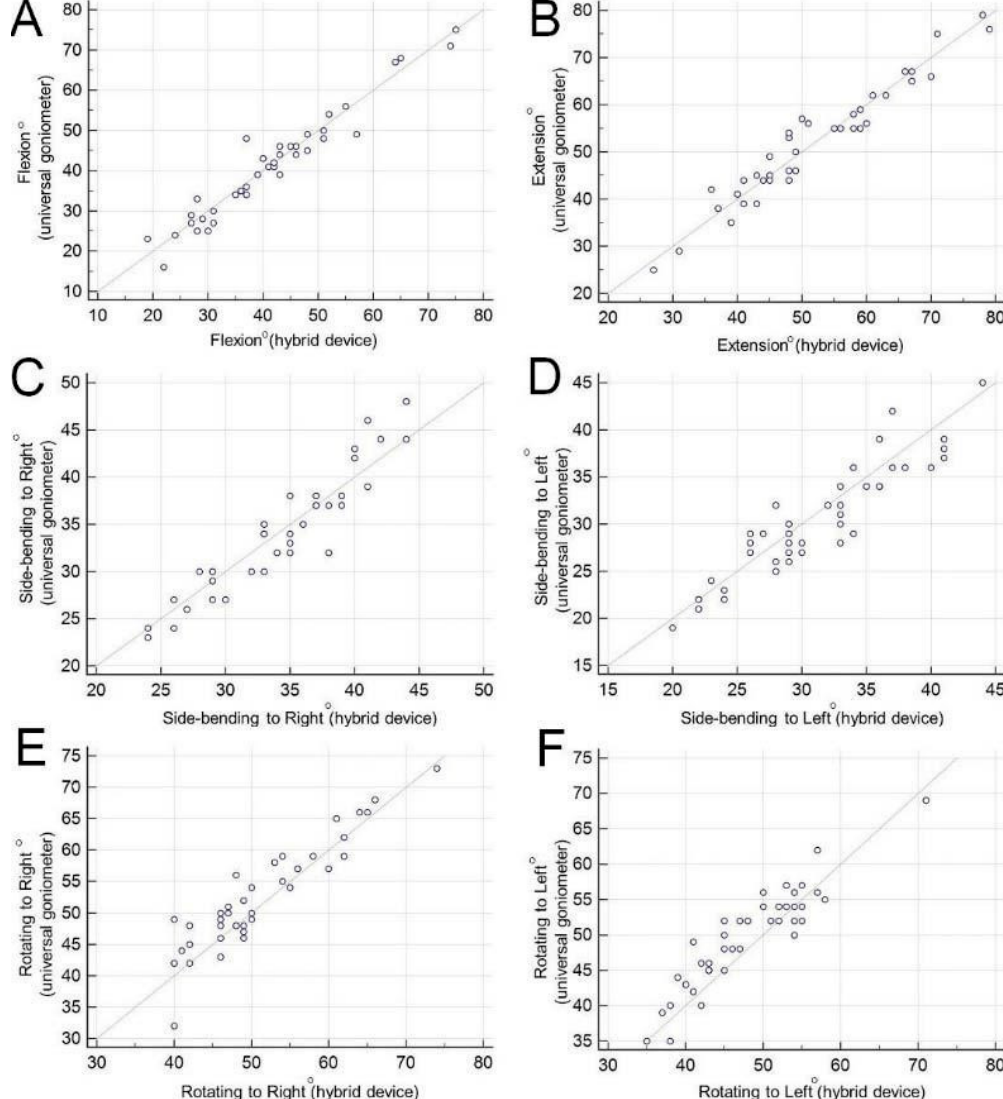
Figure 3. The correlation of craniocervical ranges measured by the hybrid device and universal goniometers in ( A ) flexion, ( B ) extension, ( C ) side-bending to right, ( D ) side-bending to left, ( E ) rotating to right and ( F ) rotating to left.